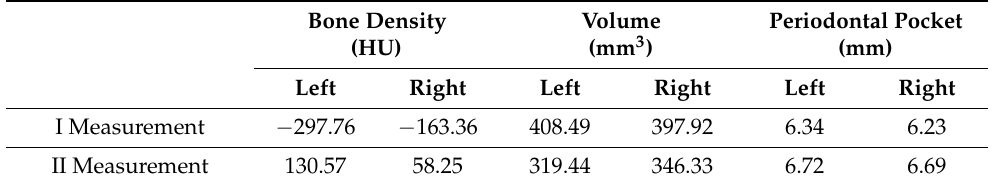
Table 1. Measurement results for bone density and volume of both left and right cavity for patient no. 1.